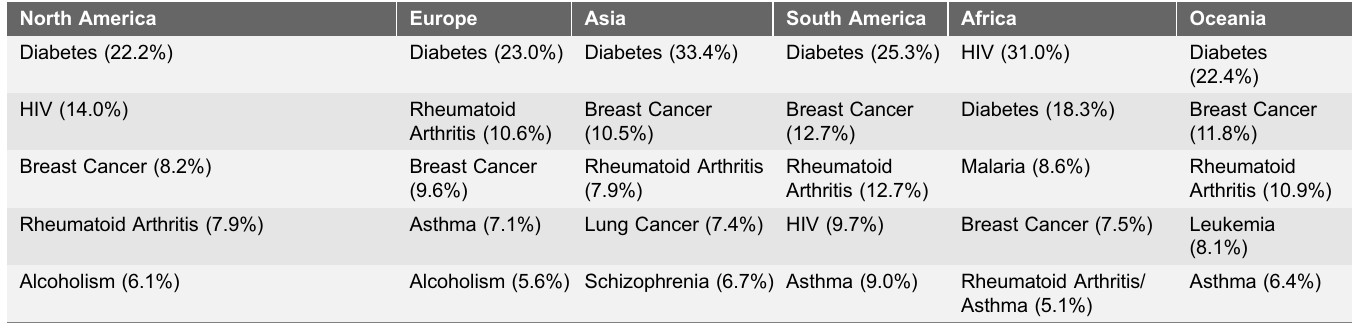
Table 5. Regional distribution of multinational clinical trials stratified by condition